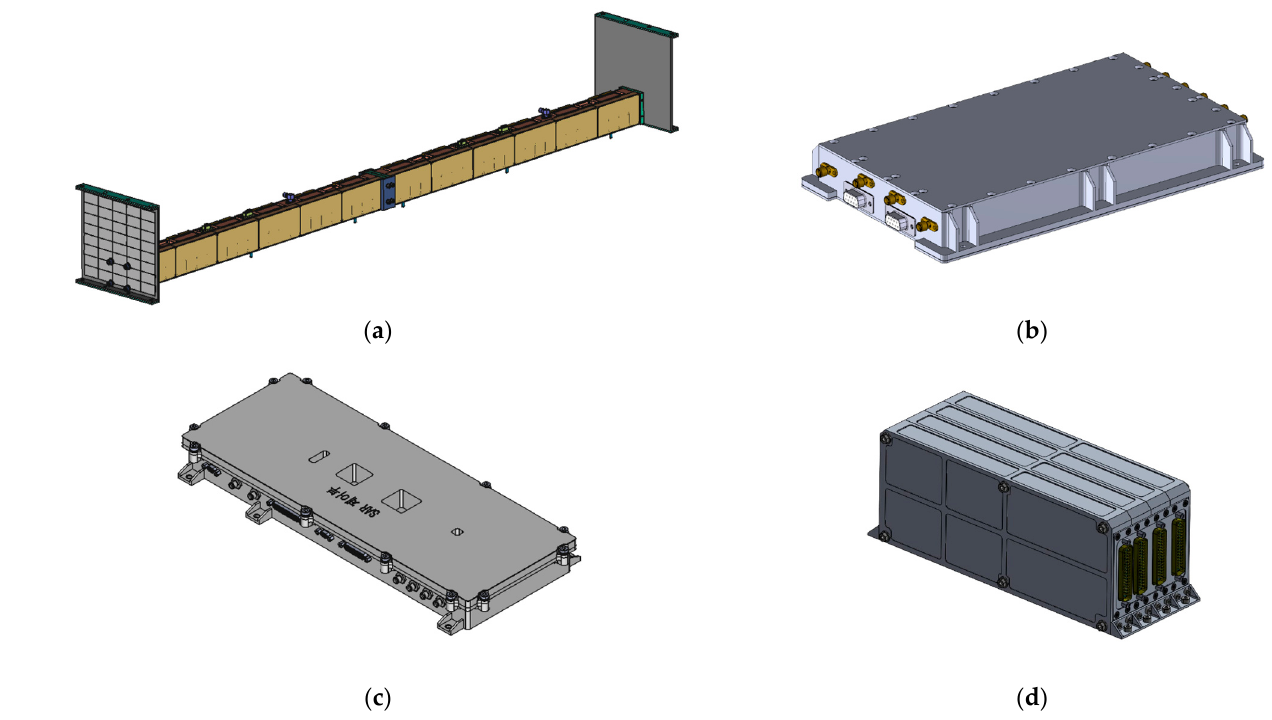
Figure 8. SAR payload units of S-STEP containing ( a ) integrated electronic front-end (I-EFE) assembly, ( b ) radio frequency unit, ( c ) digital control unit, and ( d ) power supply unit.